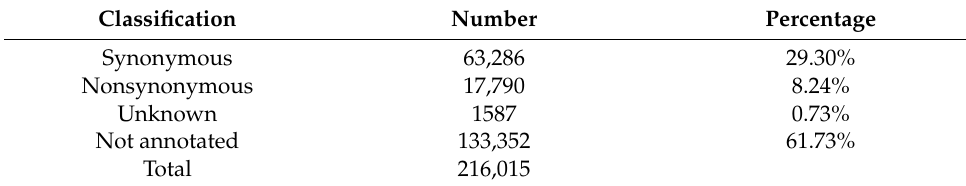
Table 5. Classification of 216,015 hypothetical SNPs using